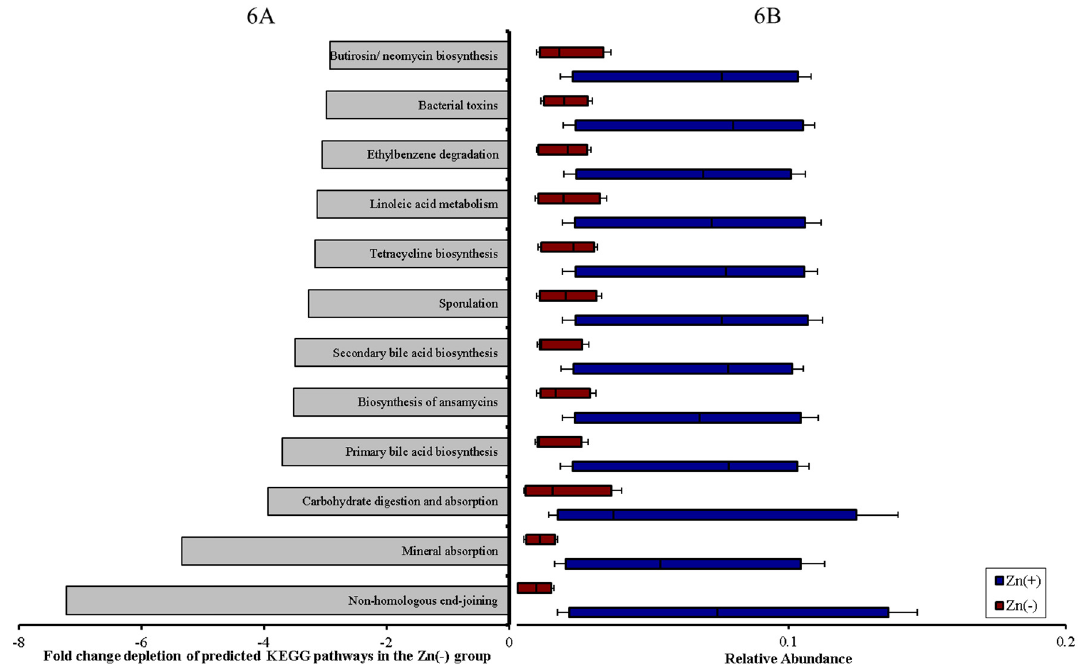
Figure 6. Functional capacity of the cecal microbiota is perturbed under conditions of Zn deficiency. ( A ) Fold change depletion of these pathways in the Zn( − ) group (all p < 0.01, Student’s t –test); ( B ) Relative abundance of differentially–expressed KEGG microbial metabolic pathways in cecal microbiota. Treatment groups are indicated by the different colors (all p < 0.05, ANOVA).